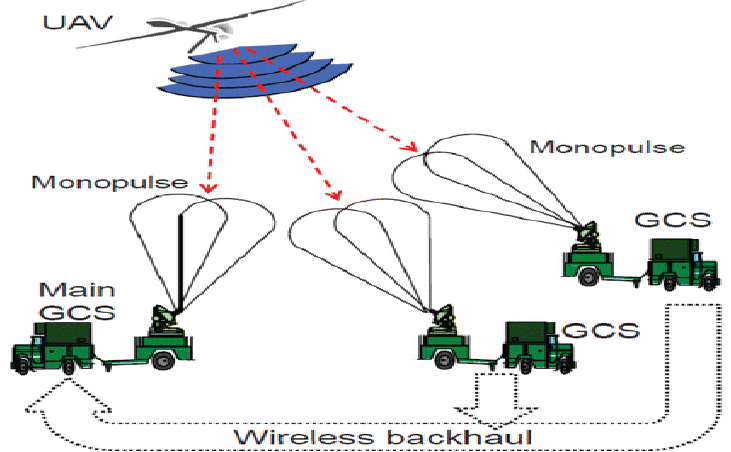
Figure 12. Monopulse UAV tracking [114]. Table 2. The other strategies that have been proposed.